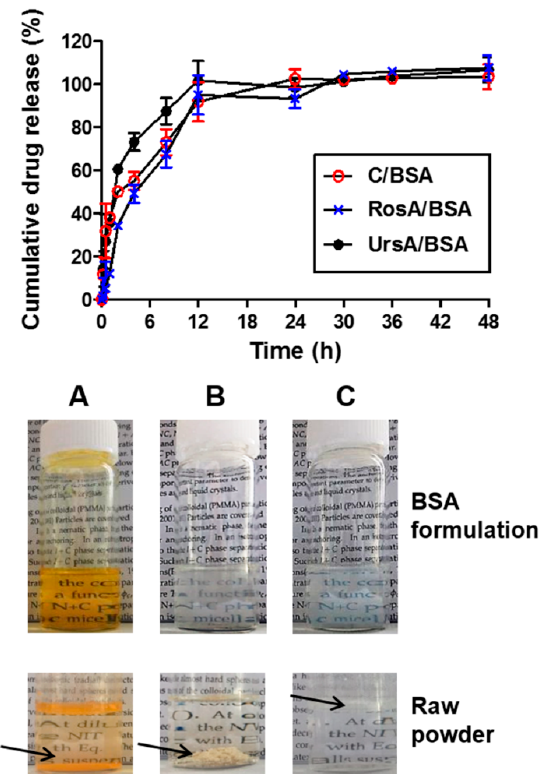
Figure 5. Drug release profiles of the BSA nanoparticles (C/BSA, RosA/BSA, and UrsA/BSA). Pictures of vials show the drug/BSA formulations with ( A ) curcumin, ( B ) RosA, or ( C ) UrsA. Raw drug powders in PBS (pH 7.4) are shown in the bottom images; the arrows indicate the precipitated drug particles at the bottom of the vial or floating in the buffer.